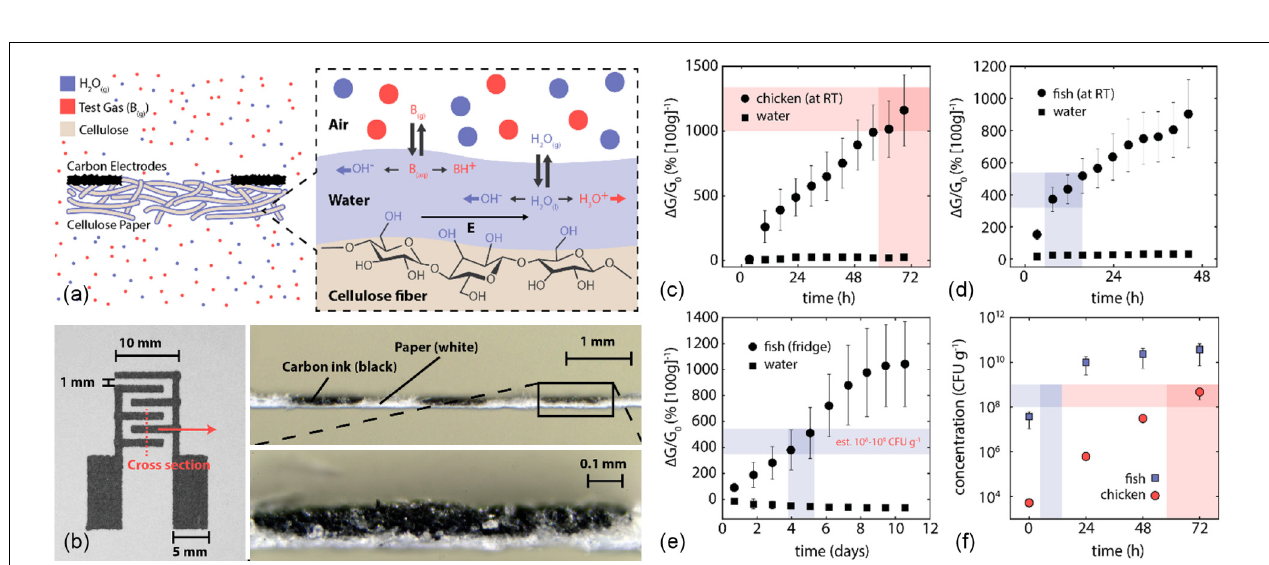
FIGURE 6 | (A) Schematic diagram displaying the equilibrium of surface adsorbed water and vapor in the gas phase. Absorbed and then dissociated base increases the concentration of mobile ions in the liquid. (B) Optical images of the printed carbon electrodes on paper (top and cross-sectional views). Relative change of sensor conductance measured for decaying (C) meat and (D) fish at room temperature, and (E) fish at 4 ◦ C. The red and gray bands in the graphs correspond to the healthy limit of microbial contamination determined by microbial cultures displayed in panel (F) . [Reproduced from Barandun et al. (2019) with permission from American Chemical